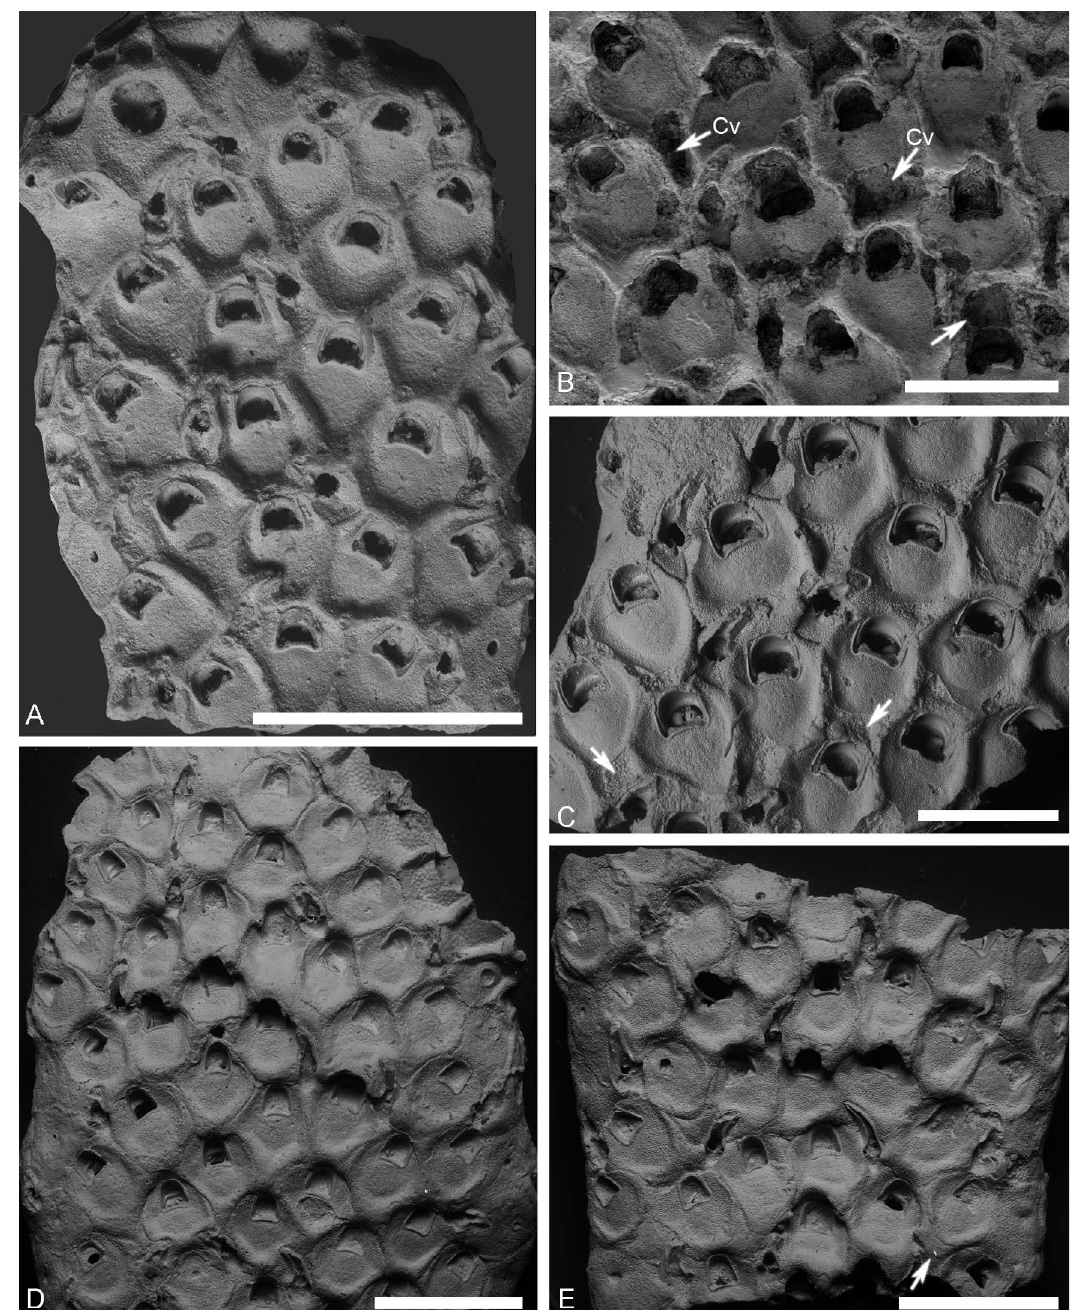
Fig. 13. Rhagasostoma gibbosum (Marsson, 1887). A–C . Erratic block of ?late Campanian age, quarry near Hrodna/Grodno (Гродна/Гродно), Grodno Region, Belarus. A . PIN 2922/218, overview of erect bifoliate colony showing autozooids, avicularia and kenozooids. B . PIN 2922/216, autozooids with proximal peripheral caverns (Cv) and broken ooecium (arrowed), avicularia. C . PIN 2922/275, non- ovicellate autozooids with proximal caverns and avicularia. D–E . Late Campanian ( Belemnitella lanceolata Zone), Emba River, Kazakhstan. D . PIN 5502/3058, overview of erect bifoliate colony showing autozooids (some ovicellate), avicularia and kenozooids. E . PIN 5502/3059, non-ovicellate and ovicellate autozooids, some with gymnocyst (arrowed), and avicularia. Scale bars: A, D–E = 1 mm; B–C = 500